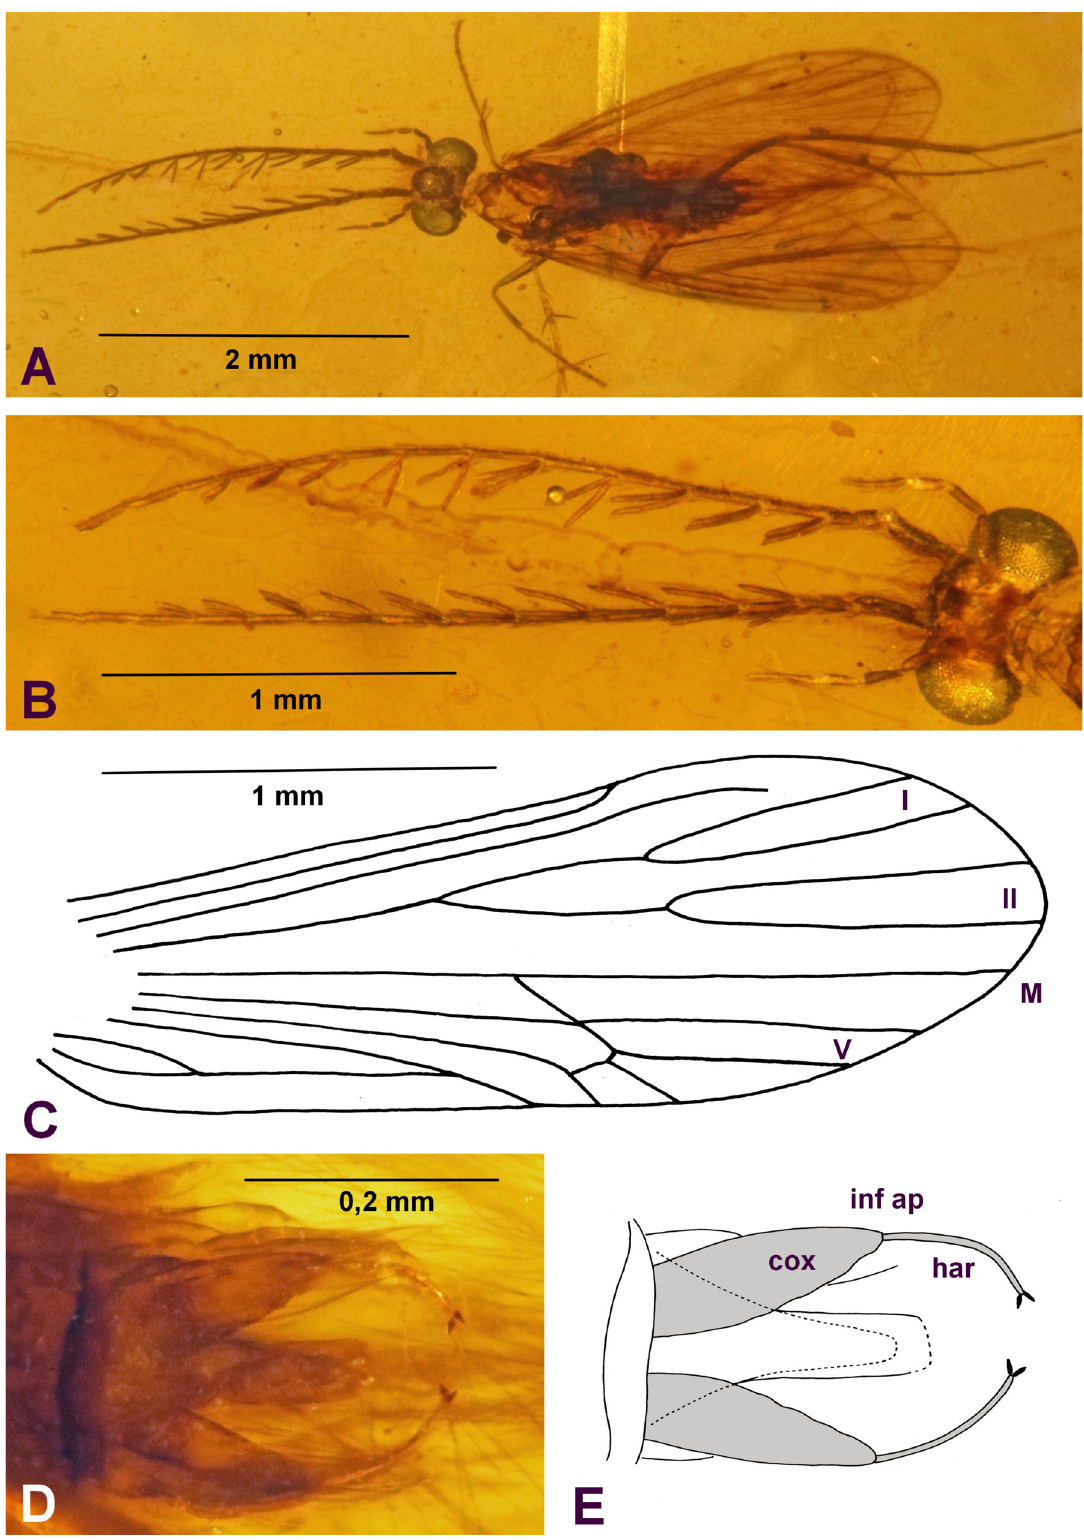
Fig. 2. Palaeopsilotreta burmanica sp. nov. (ZFMK-TRI000813) A . Holotype male in dorsal view. B . Head with maxillary palps and bipectinate antennae. C . Drawing of a forewing. D . Male genitalia in ventral view. E . Drawing of the male